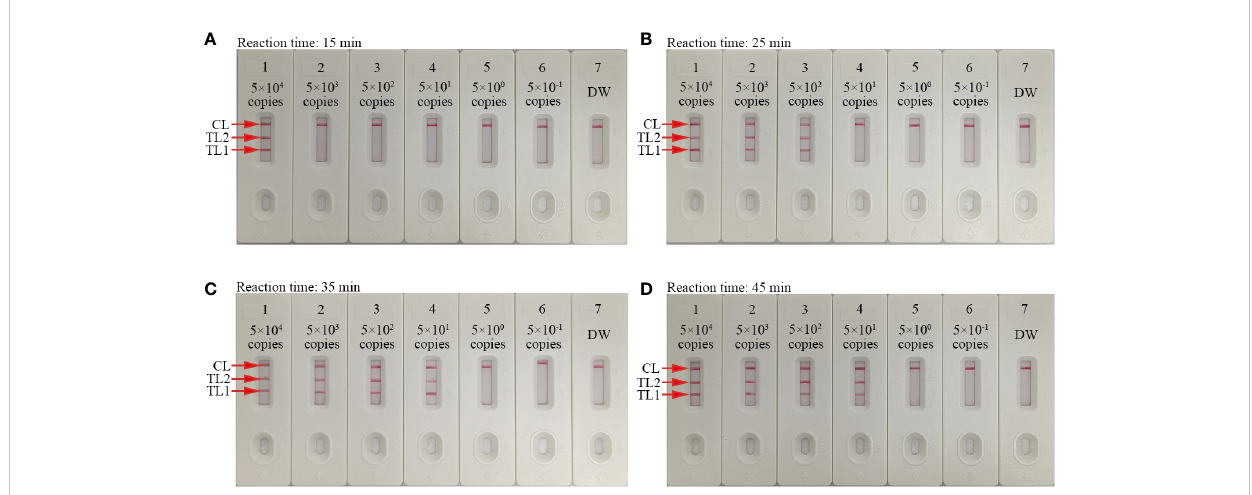
FIGURE 6 Ampli fi cation time optimization for the mLAMP-AuNPs-LFB assay Four LAMP reaction times were evaluated at 67°C: (A) 15 min, (B) 25 min, (C) 35 min, and (D) 45 min. AuNPs-LFBs 1 – 7 represent nucleic acid template levels 5.0×10 4 , 5.0×10 3 , 5.0×10 2 , 5.0×10 1 , 5.0×10 0 , and 5.0×10 -1 copies and negative control (DW), respectively. Results were analyzed using AuNPs-LFBs. The optimal LoD occurred with a 35 min reaction time (C) . Key: CL, control line; TL1, test line one; TL2, test line